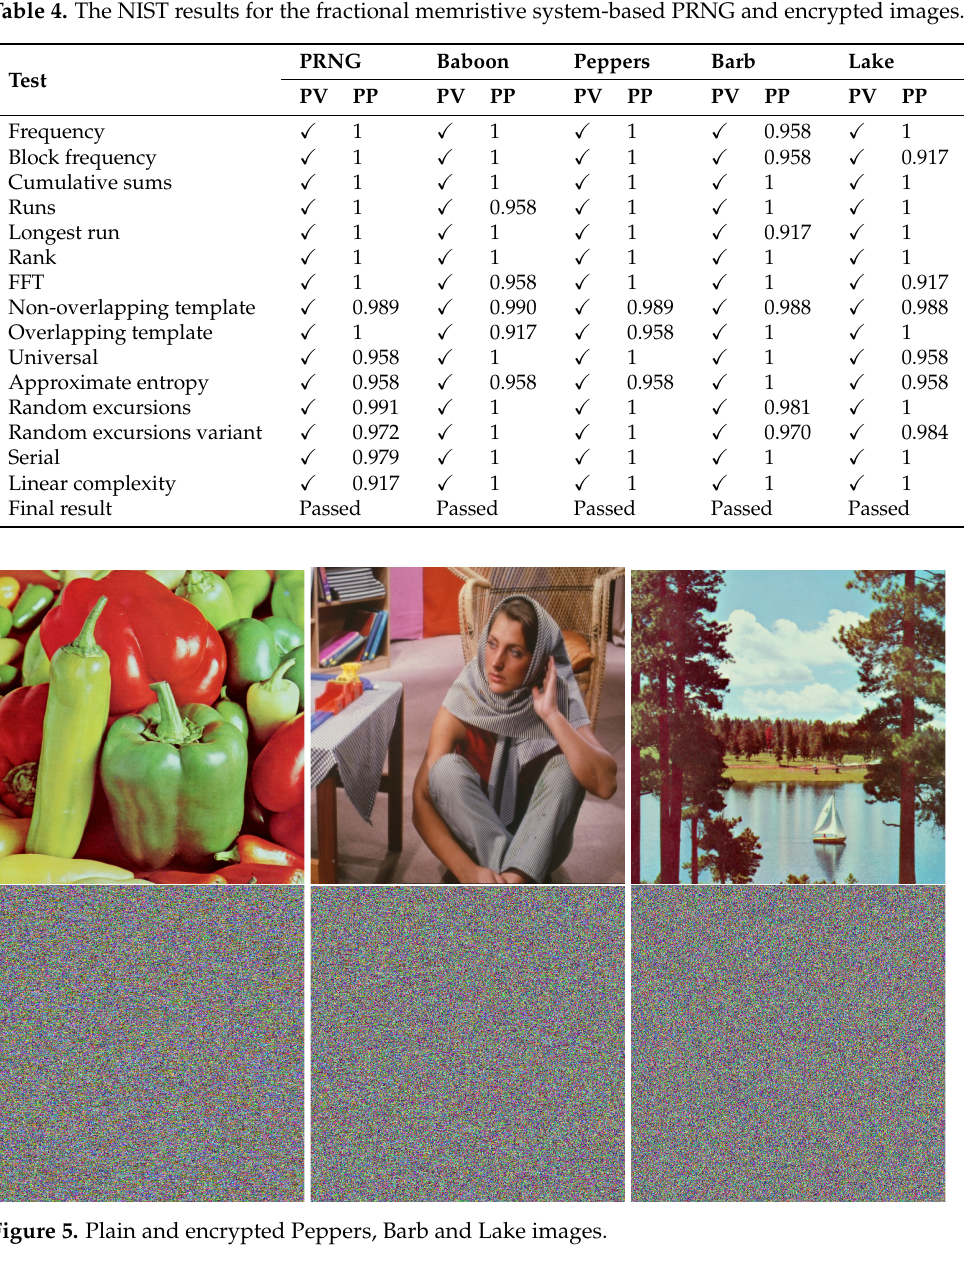
Table 4. The NIST results for the fractional memristive system-based PRNG and encrypted images.